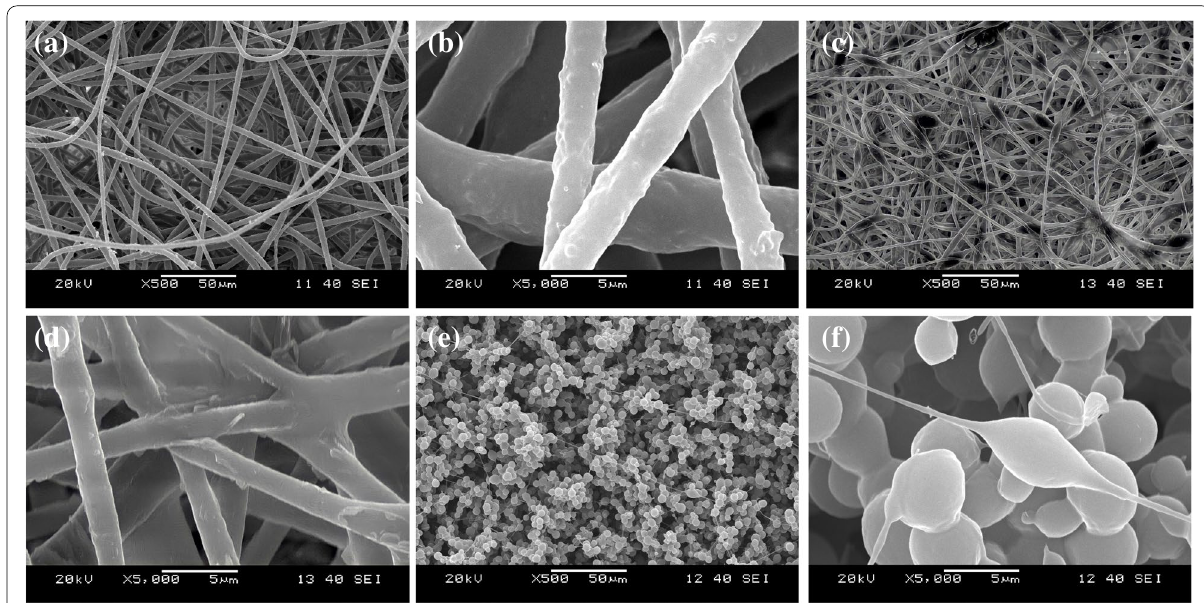
Fig. 1 SEM images of pure PHBV fibers at two magnifications (500x, 5000x). a , b Beadless microfibers from a 21 wt.% PHBV solution; c , d beads on microfibers from a 12 wt.% PHBV solution; e , f beaded nanofibers produced from a 4 wt.% PHBV